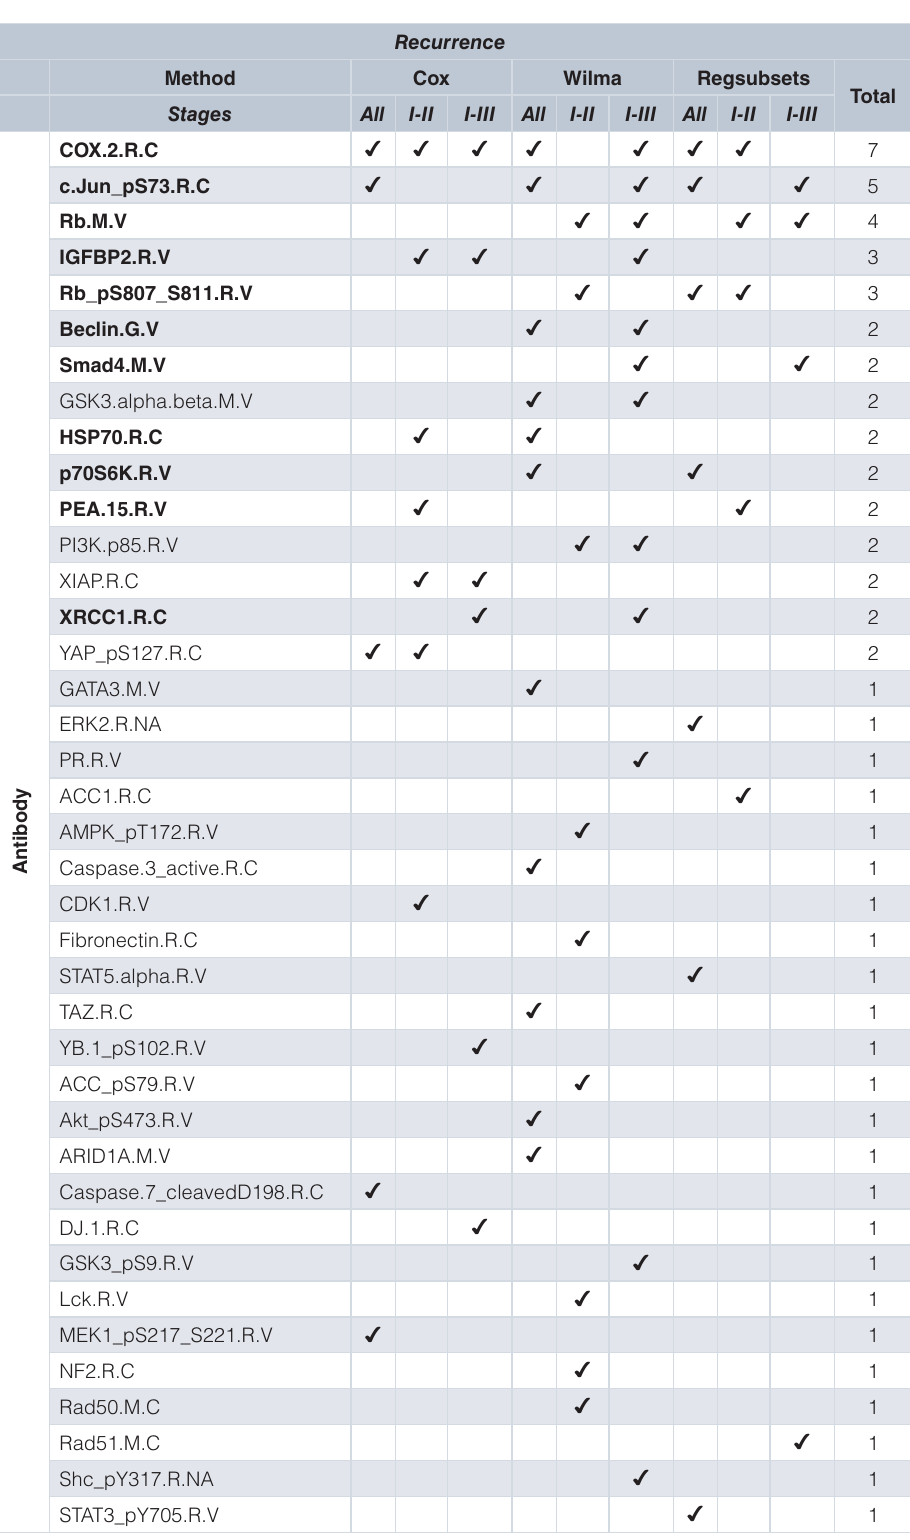
Supplementary Table 4. All proteins associated with recurrence, sorted in descending order by the number of times